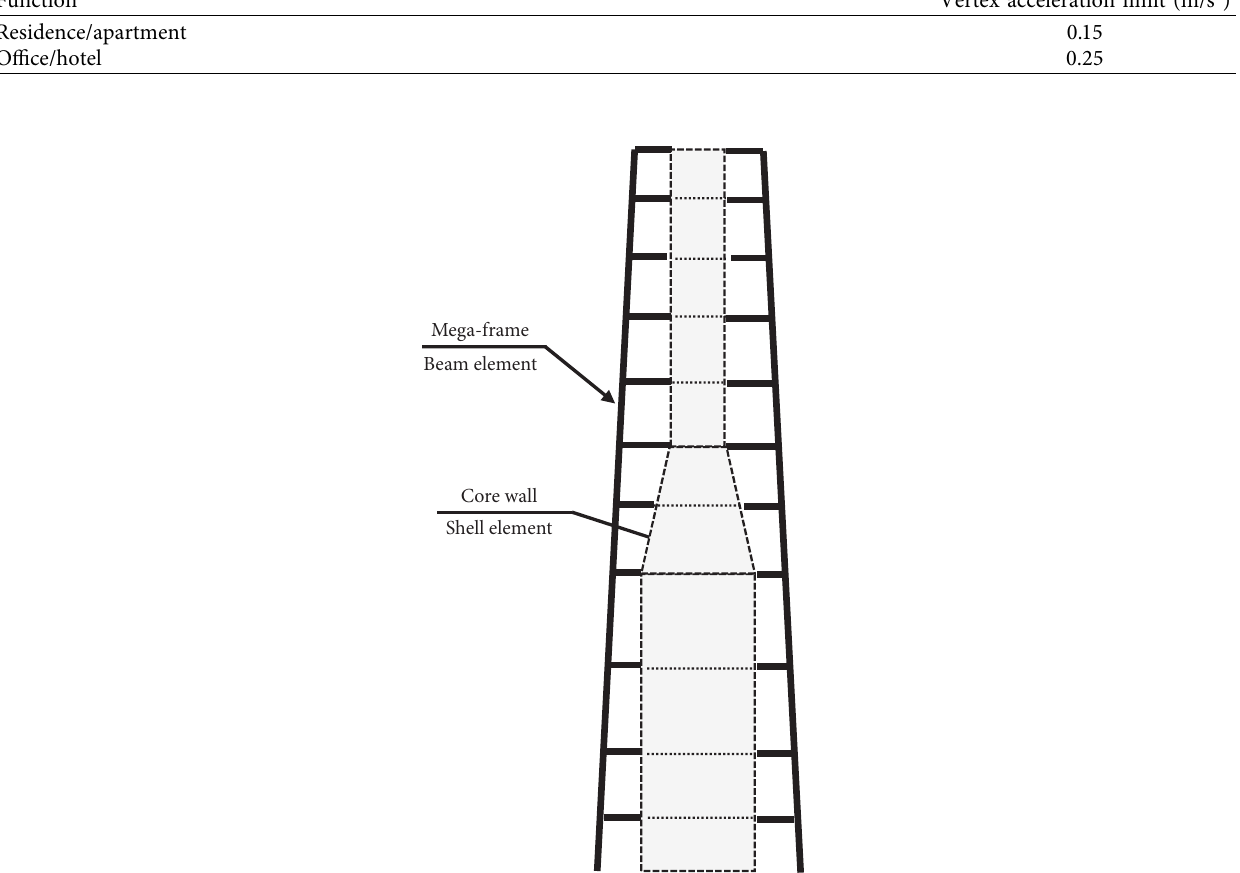
Figure 3: Composition of the acceleration prediction simplified